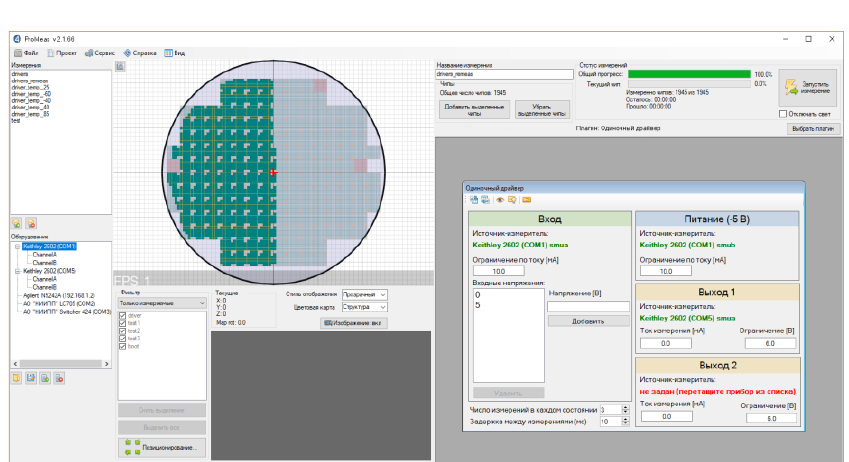
Fig. 4. Software for automated on-wafer probe measurements.